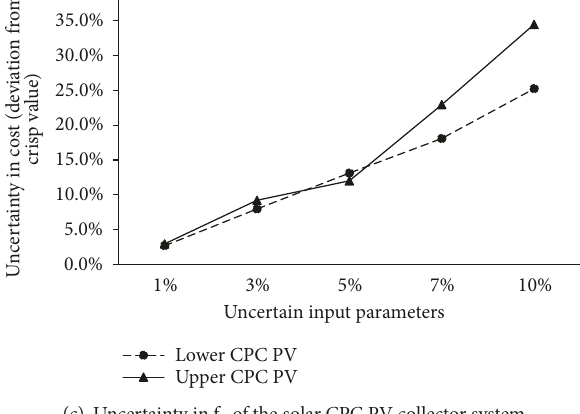
(a) Uncertainty in f 1 of the solar CPC PV collector system (b) Uncertainty in f 2 of the solar CPC PV collector system